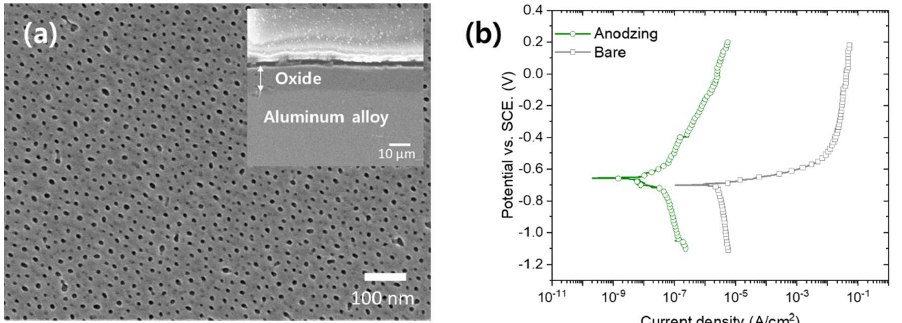
Figure 1. ( a ) SEM images and ( b ) potentiodynamic polarization curve (in 3.5 wt.% NaCl solution) of anodized aluminum alloy 6061.